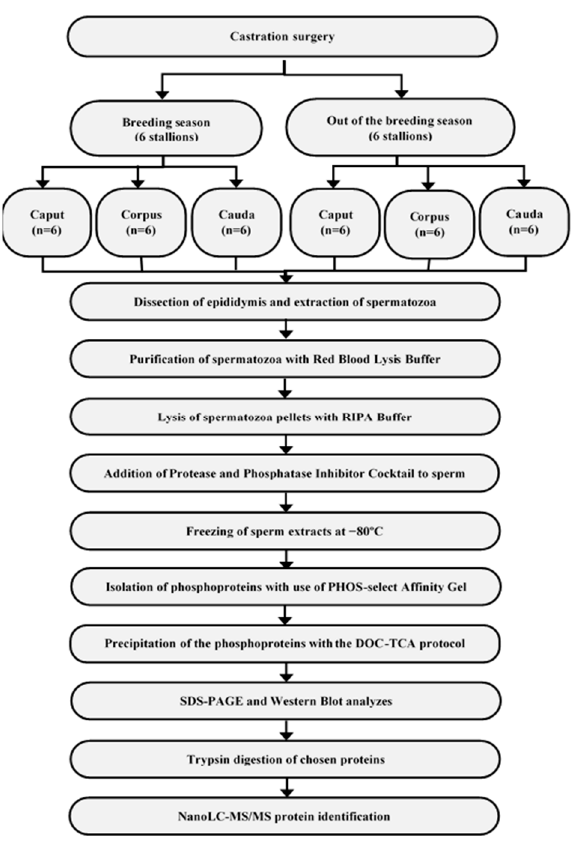
Figure 1. The scheme presenting the step ‐ by ‐ step course of action taken during the survey conduct ‐